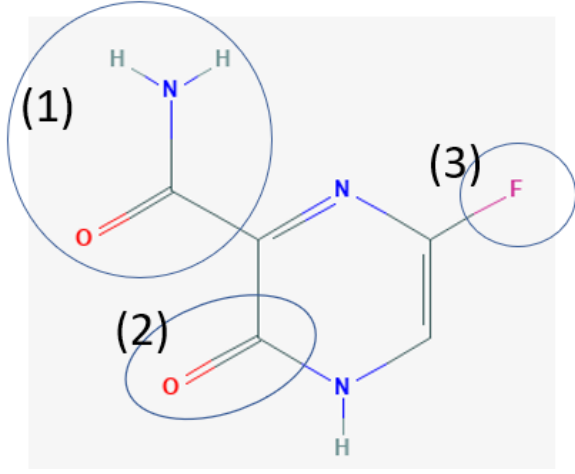
Fig. 2. Chemical structure of favipiravir 42